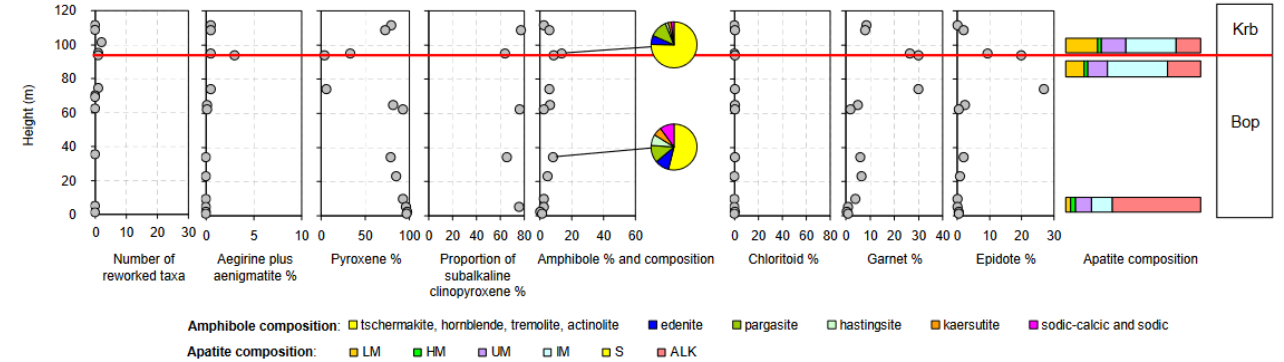
Figure 8. Variations in heavy mineral provenance character and reworked taxa at Kap Brewster. ster. Bop = Bopladsdalen Formation, Krb = Krabbedalen Formation. LM = low and Bop = Bopladsdalen Formation, Krb = Krabbedalen Formation. LM = low and medium grade meta ‐ morphic and metasomatic, HM = high grade metamorphic, partial melts, leucosomes, UM = ultra ‐ mafic igneous, IM = mafic igneous including mafic I ‐ type granitoids, S = felsic igneous including S ‐ type and felsic I ‐ type granitoids, ALK = alkaline igneous.